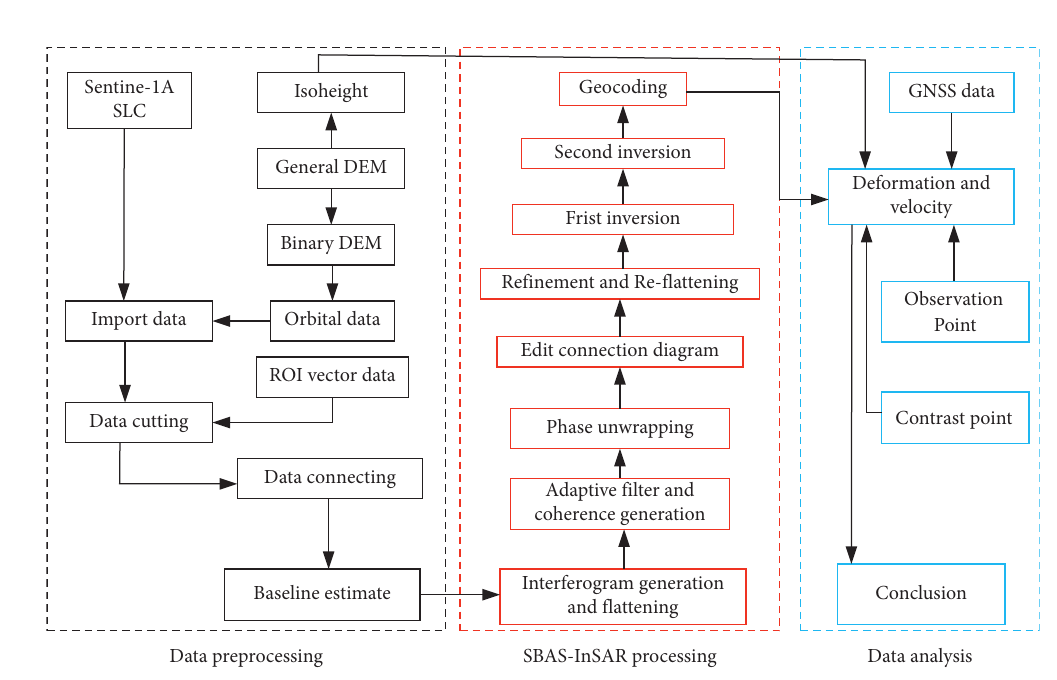
Figure 3: Data processing flow